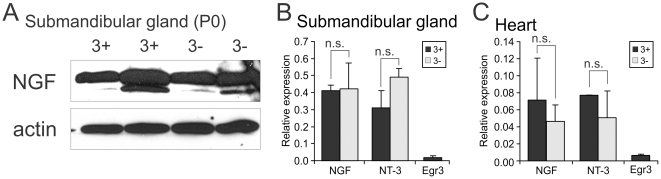
Normal NGF and NT-3 expression in two target tissues with markedly abnormal sympathetic innervation in Egr3-deficient mice.(A) Western blotting for NGF and actin (loading control) showed that NGF protein levels were similar in submandibular glands between wild type (3+) and Egr3-deficient (3-) mice (submandibular gland protein lysates from two different newborn mice shown). qPCR to measure the level of NGF and NT-3 transcript expression in (B) submandibular gland and (C) heart showed no significant differences between 3+ and 3- mice. Egr3 expression in both tissues was low and near detection threshold. (results represent the mean ± standard error of tissues from 3–4 animals 8–10 weeks old of each genotype; n.s.  =  non-significant, Student's t test).